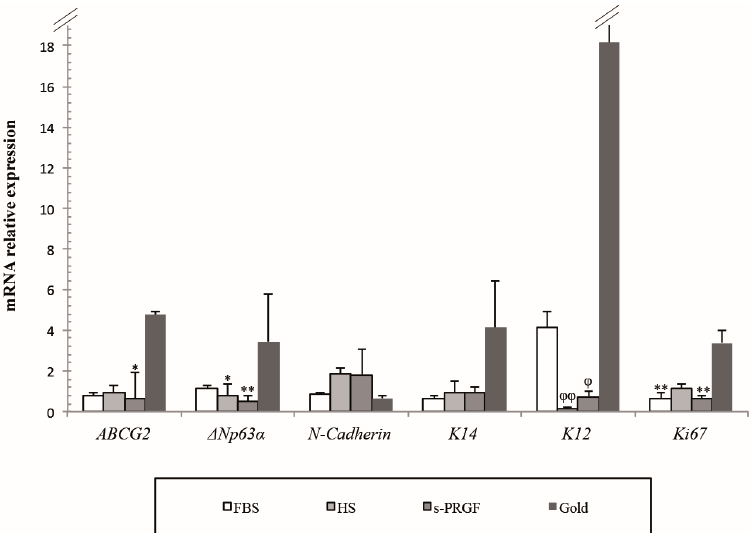
Figure 3. Figure 3. Relative mRNA expression of several cell markers in LESCs obtained from explants and gold standard cultures treated with FBS or two di ff erent human sera. * Indicates significant di ff erences between the gold standard culture and the indicated treatments, and ϕ between the FBS and the indicated treatments. (* p < 0.05; ** p < 0.01) ( ϕ p < 0.05; ϕϕ p <